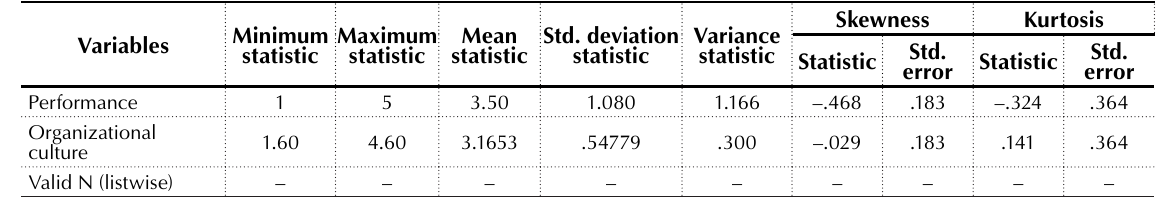
Table 6. Correlation between the variables